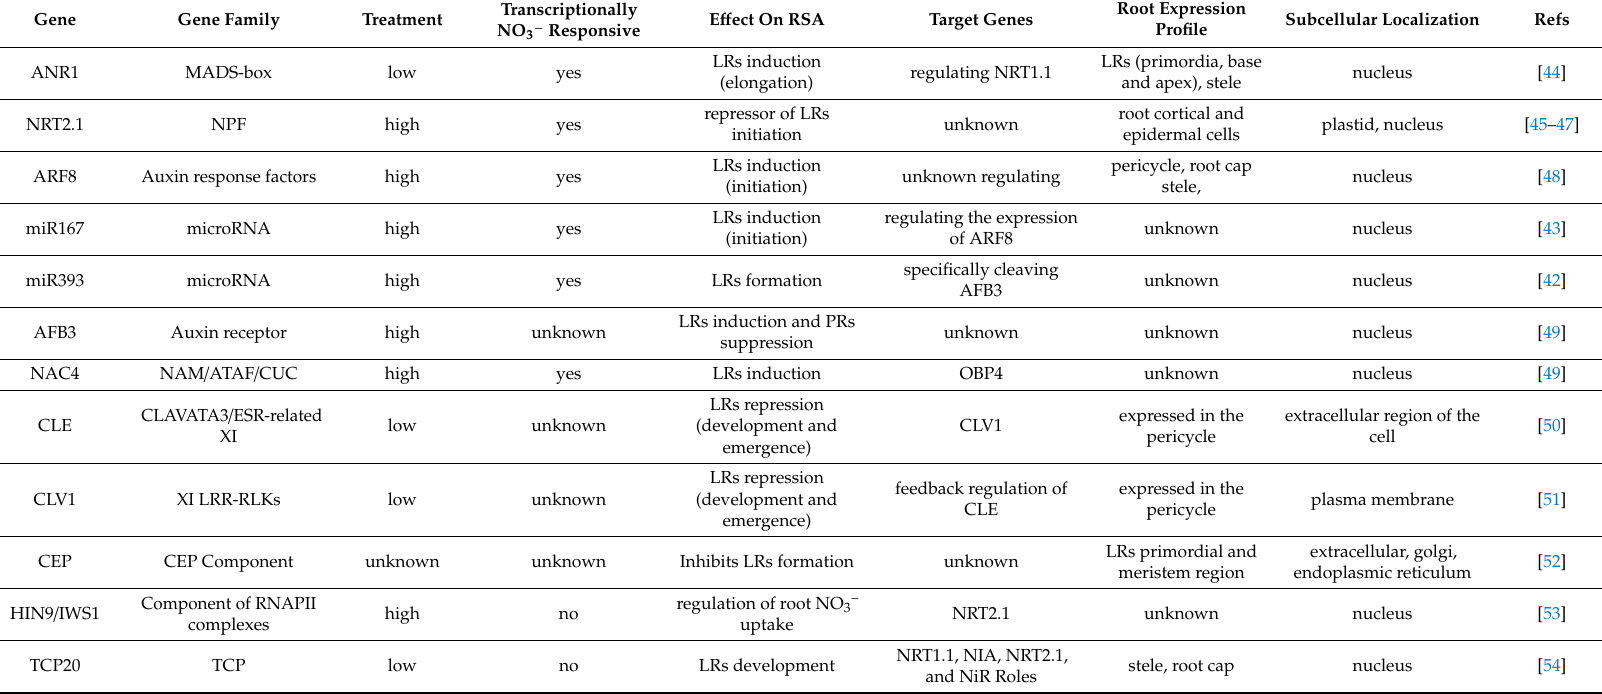
Table 3. Long Term Nitrate Responsive